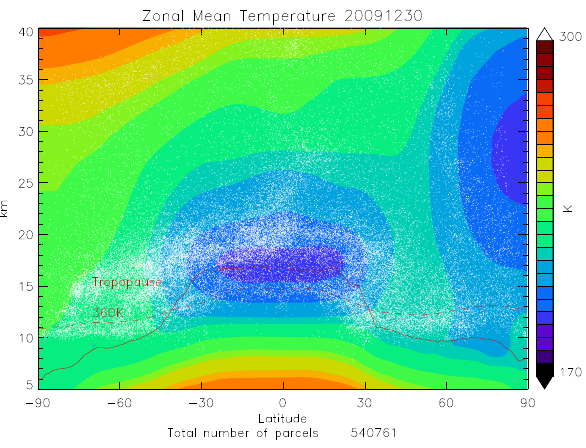
Fig. 1. Parcel distribution for diabatic experiment on 30 Decem- ber 2009 thinned by a factor of 10 for visibility. Injection began 1 January 2000. Colors show the zonal mean temperature distribu- tion from MERRA. Red lines identify the zonal mean 360K and tropopause levels. Parcels moving below about 10km are elimi-